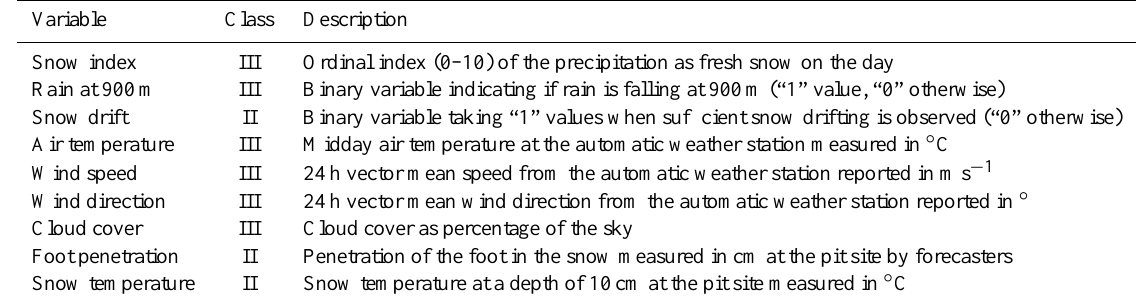
Table 2. List of the 9 meteorological and snowpack variables recorded daily in the winter season. Variable